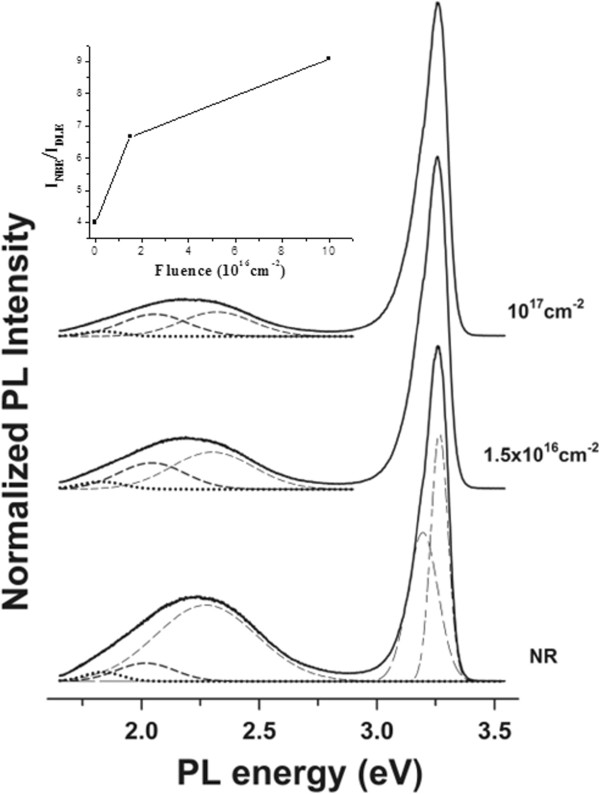
μPL spectra. Unirradiated (NR) and irradiated areas with fluences of 1.5 × 1016 cm−2 and 1017 cm−2. The spectra, normalized to the band-to-band recombination, show the diminution of the visible band intensity as the irradiation energy increases. Gaussian deconvolution bands are also shown. The inset shows the intensity ratio INBE/IDLE as a function of the irradiation fluence.